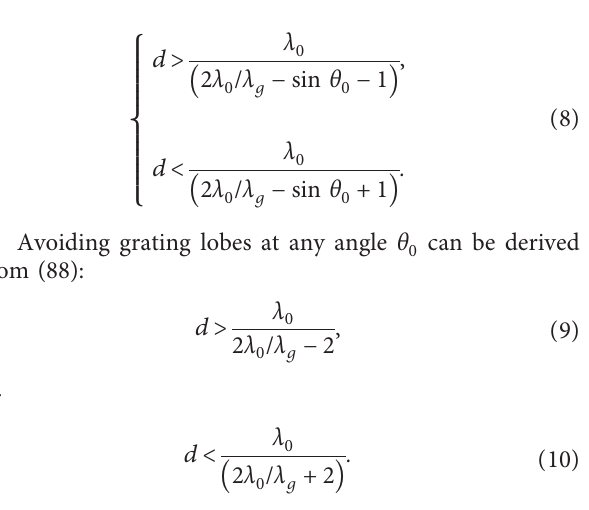
Figure 2: Schematic diagram of beam scanning of